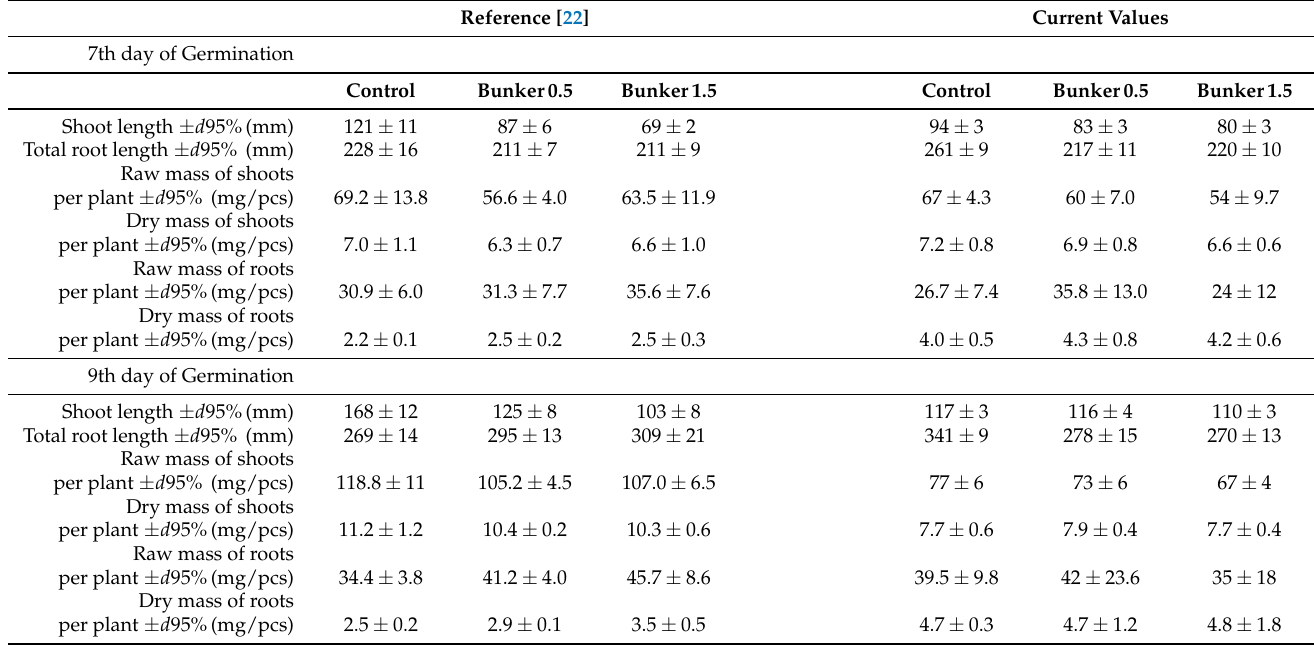
Table 5. Morphophysiological characteristics of seedlings on the 7th and 9th days of development. Comparison of current work’s data with reference work [22]. Designations of variants coincide with designations in Table 1.